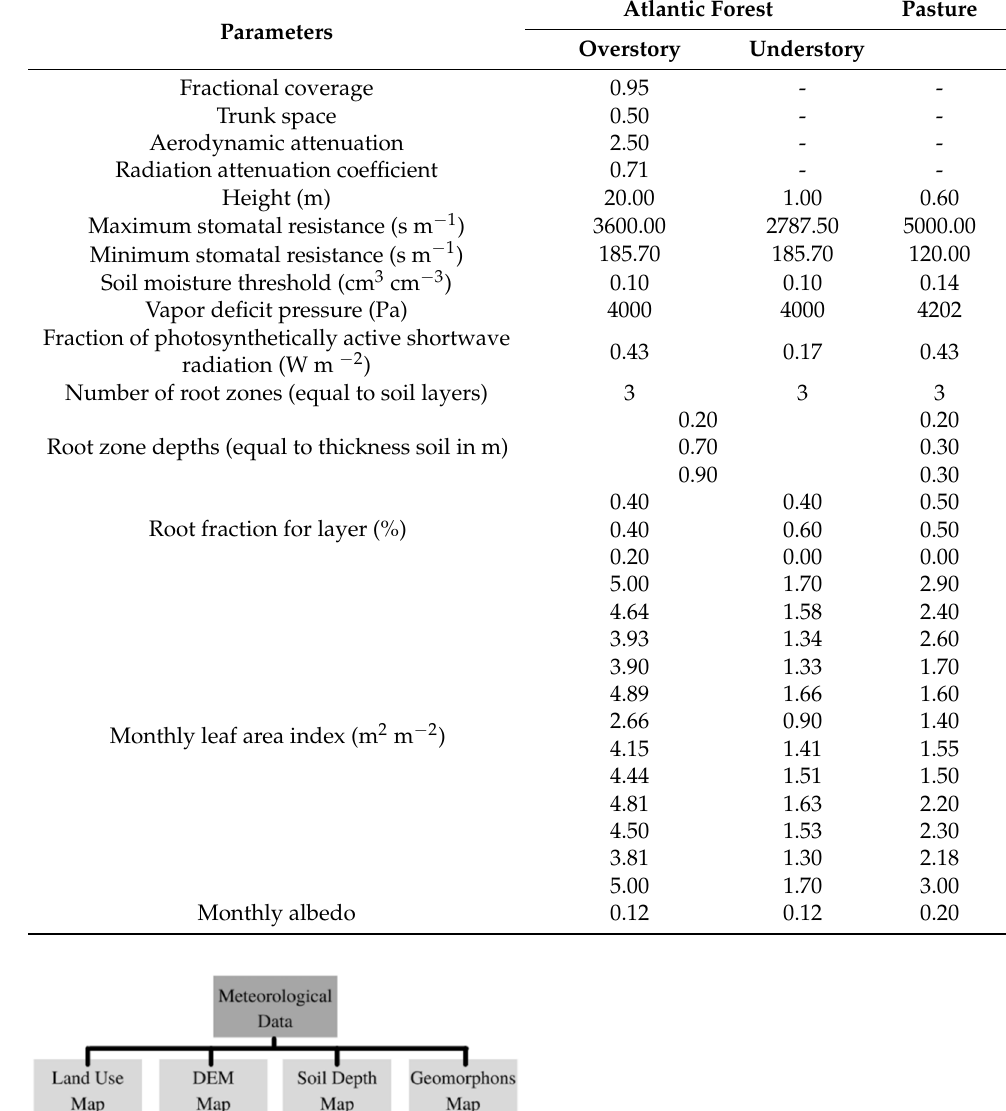
Table 1. Final vegetation parameters used in the DHSVM simulations [4].